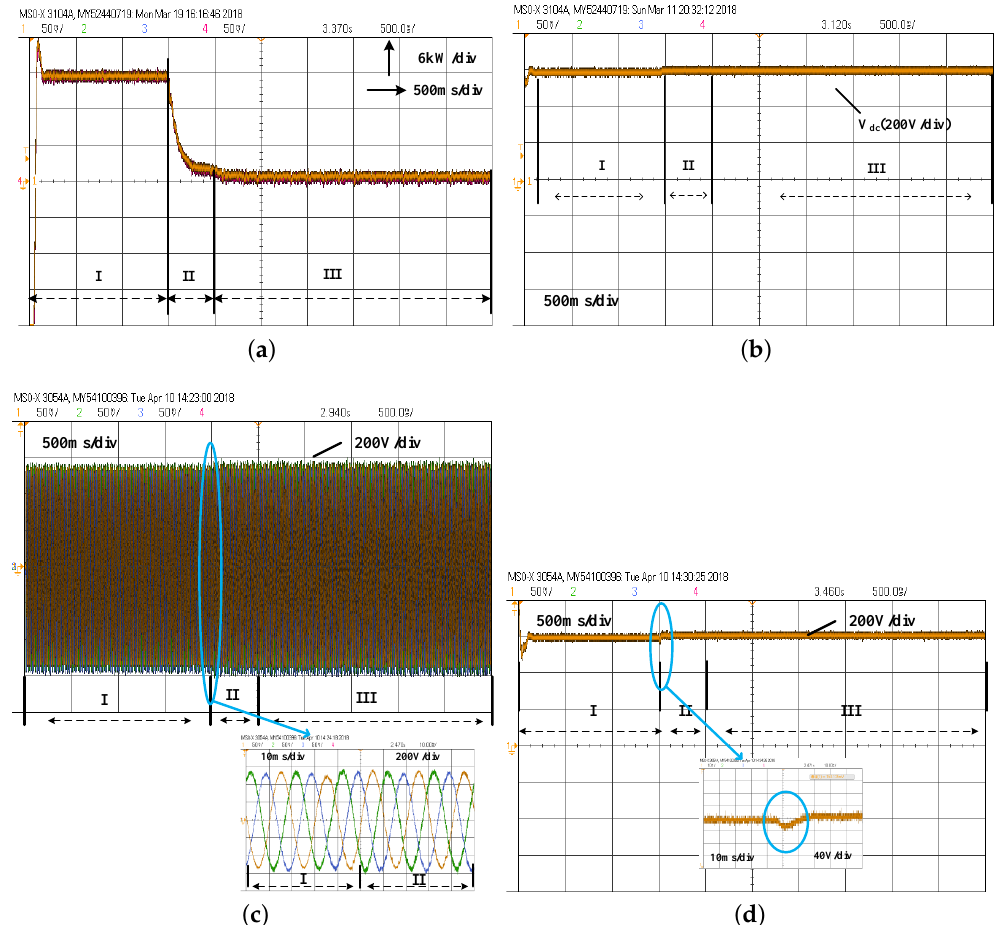
Figure 12. Test results of Case 1: ( a ) output power of BPCs; ( b ) DC voltage; ( c ) AC voltage; and ( d ) DC voltage in microgrid without smooth transition